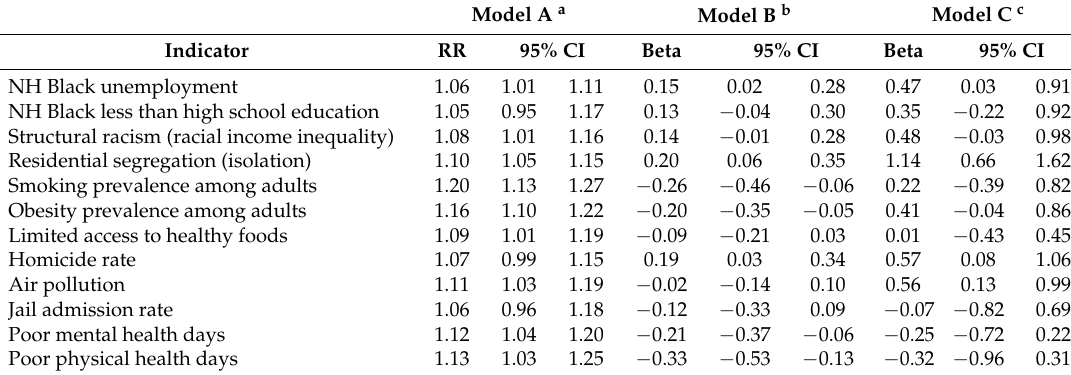
Table 3. Associations between social determinants indicators and infant mortality rates in 100 MSAs, 2010–2013. * Model A a Model B b Model C c Indicator NH Black unemployment